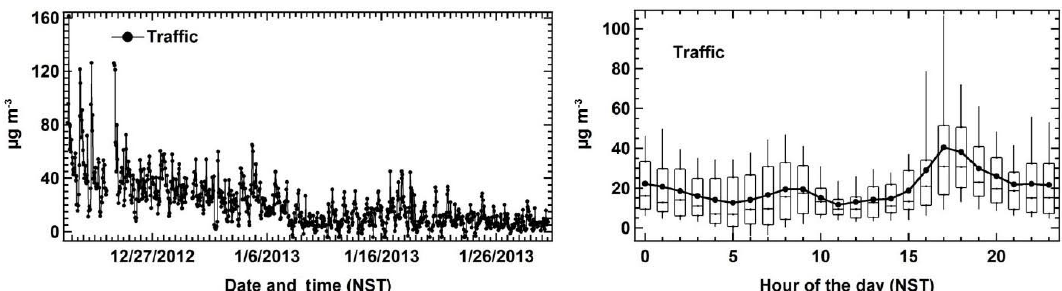
Figure 4. Time series and diel box and whisker plot for Factor 1